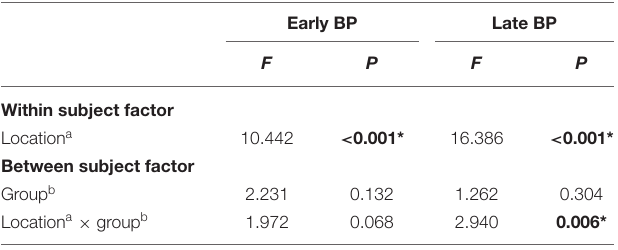
TABLE 2 | Repeated-measures analysis of variance of mean amplitudes of early and late Bereitschaftspotential (BP).